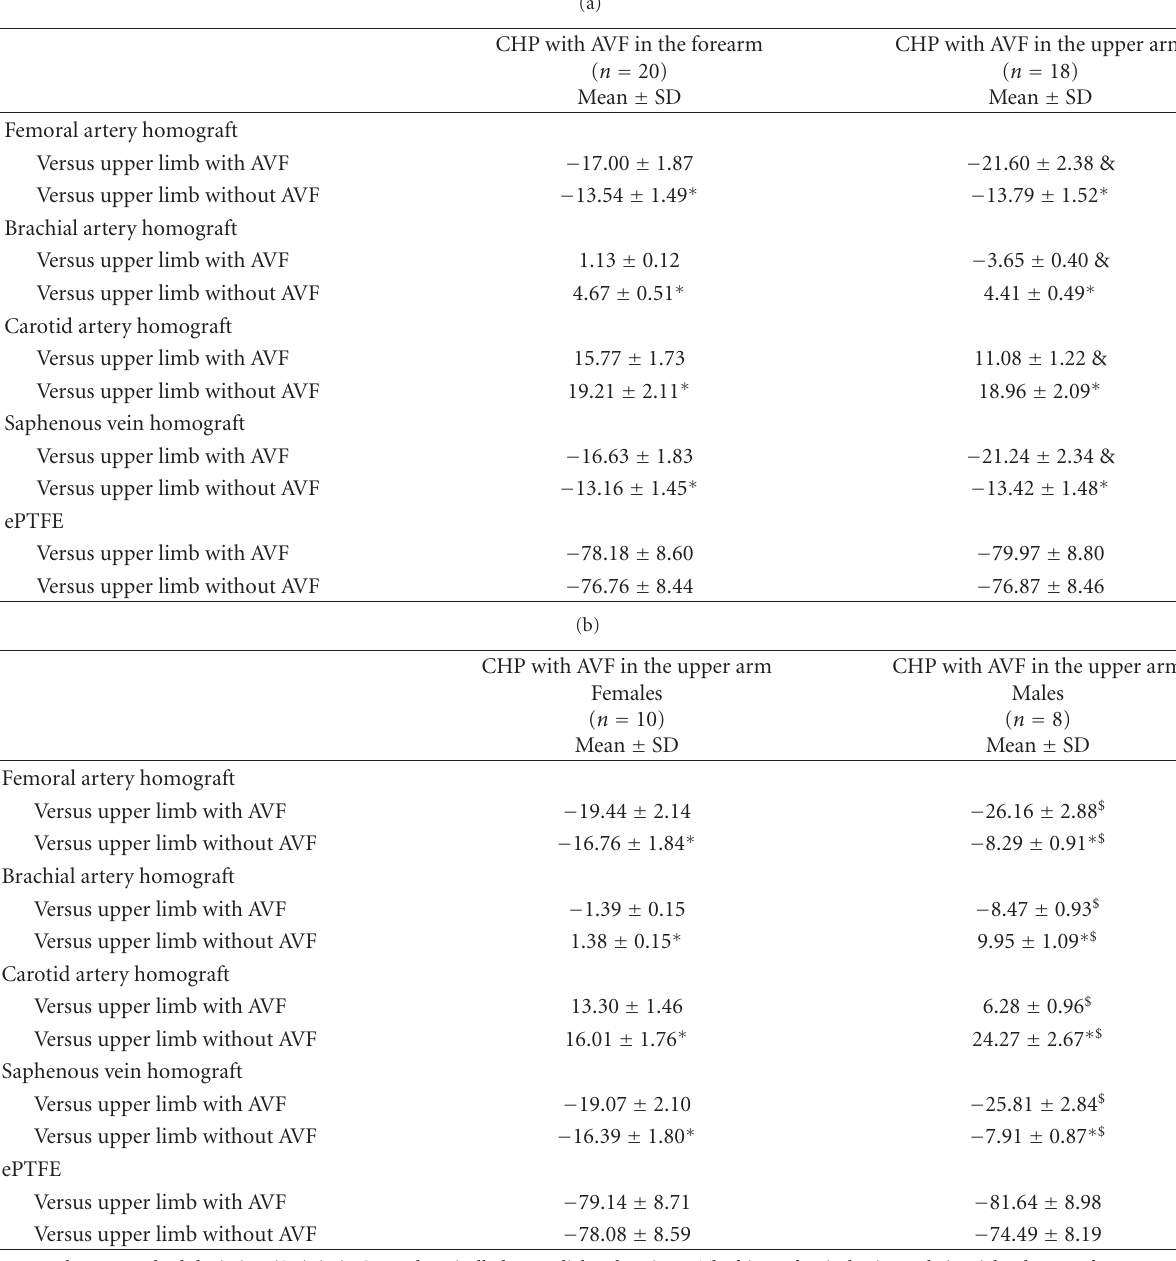
Table 2: Biomechanical mismatch among vascular substitutes and carotid-brachial pathways of CHP with AVF at the forearm or at the upper arm